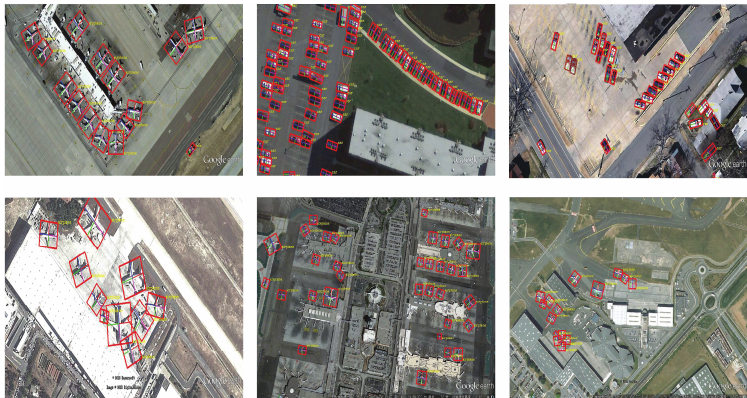
Figure 10. Detection results of the student network on the UCAS-AOD